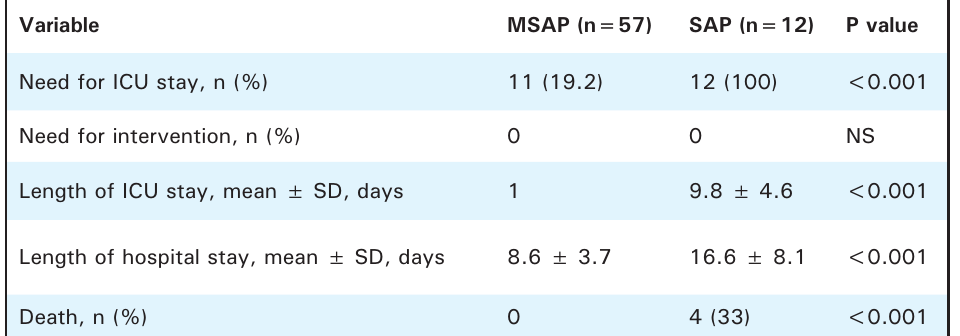
Table 6. Comparison between MSAP and